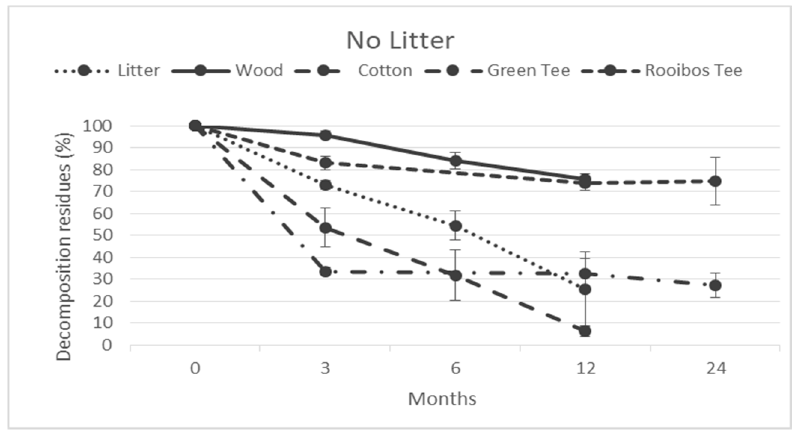
Figure 7. Decomposition rate of different quality organic matter after 3, 6, 12 and 24 months in the soils of No Litter (NL) plots of the DIRT experiment (average of 9 replicates with standard deviation).